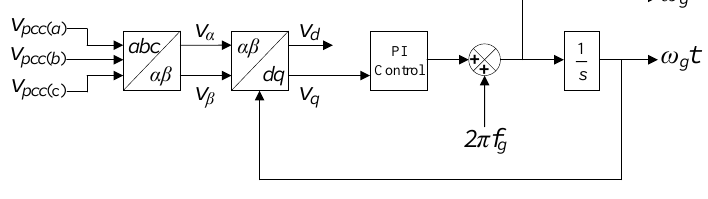
Figure 8. Phase locked loop block diagram.